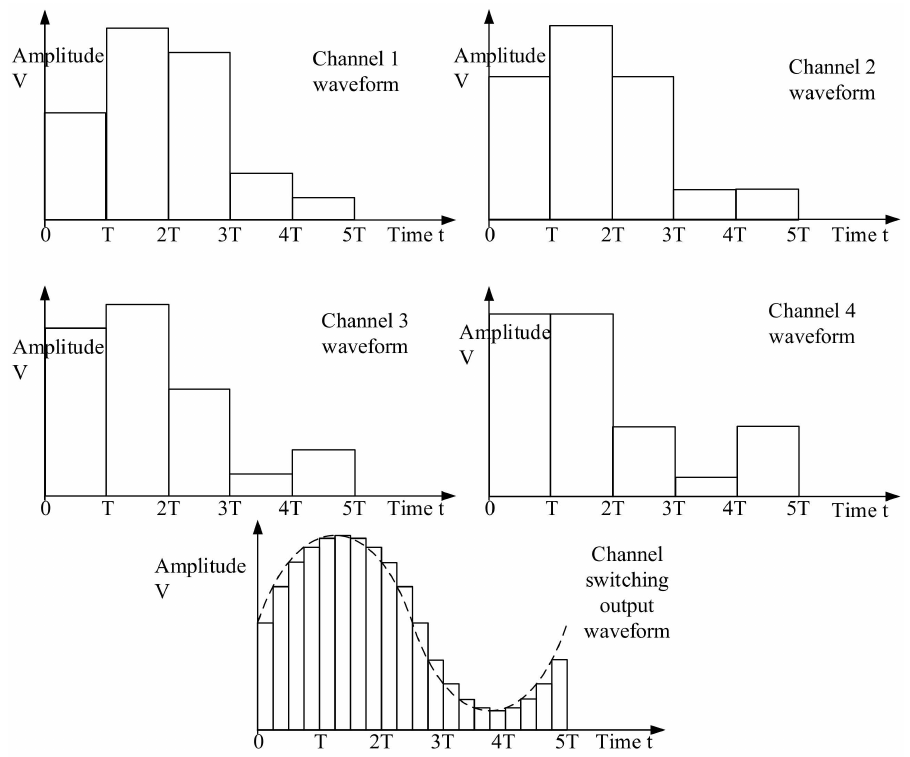
Figure 5. The relationship between the output of each channel and the output of the